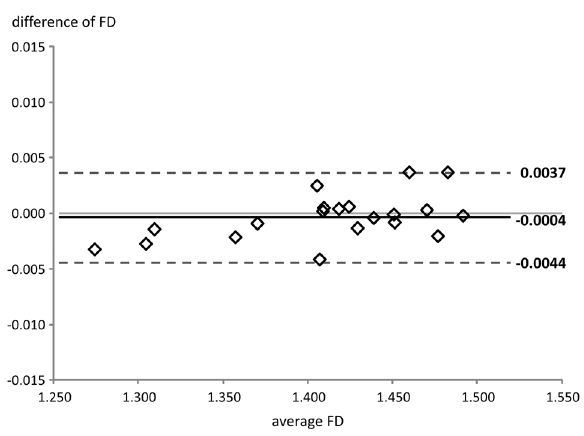
Figure 4. Bland–Altman plot for intra-rater agreement. FD, fractal